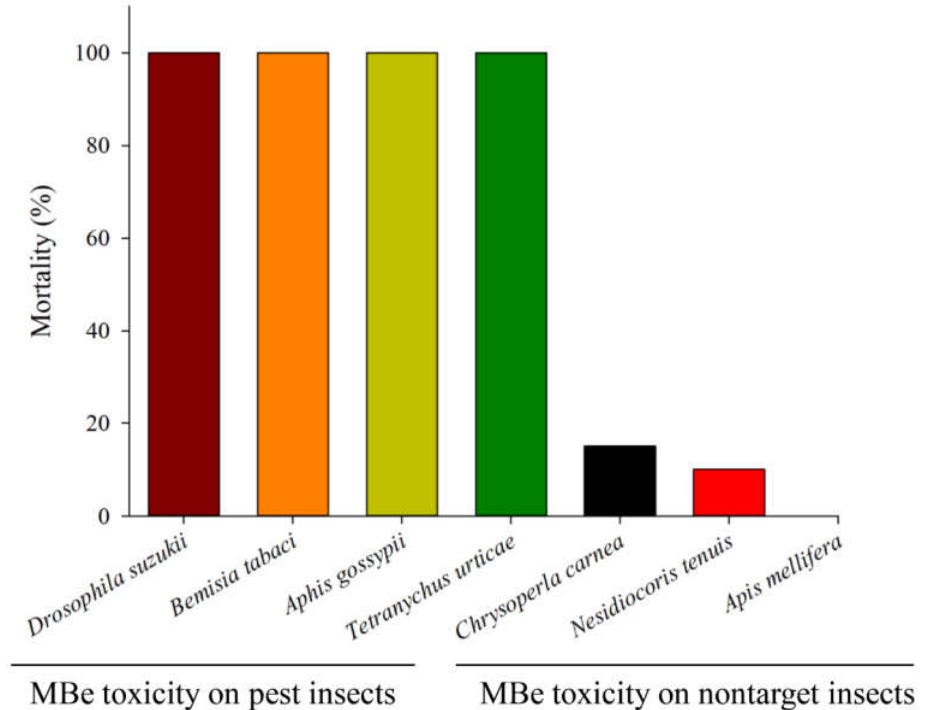
Figure 2. Toxicity differences of methyl benzoate against various arthropod pests and nontarget organisms: Mortality data from 1% MBe concentration after 48 h of exposure. The image was adapted from Feng and Zhang (licensed under CC BY 4.0), Mostafiz et al., and Zhu et al. (licensed under CC BY 4.0) [14,46–48,81,82].